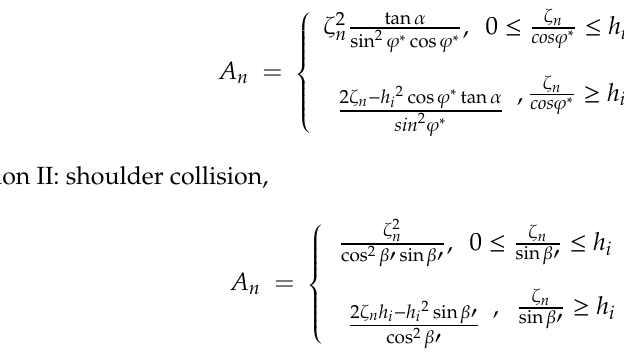
Figure 9. Side view of the two contact areas: ( a ) Case I with an indentation that does not go through the ice thickness hi ; ( b ) Case II with an indentation penetrating through the ice thickness hi .